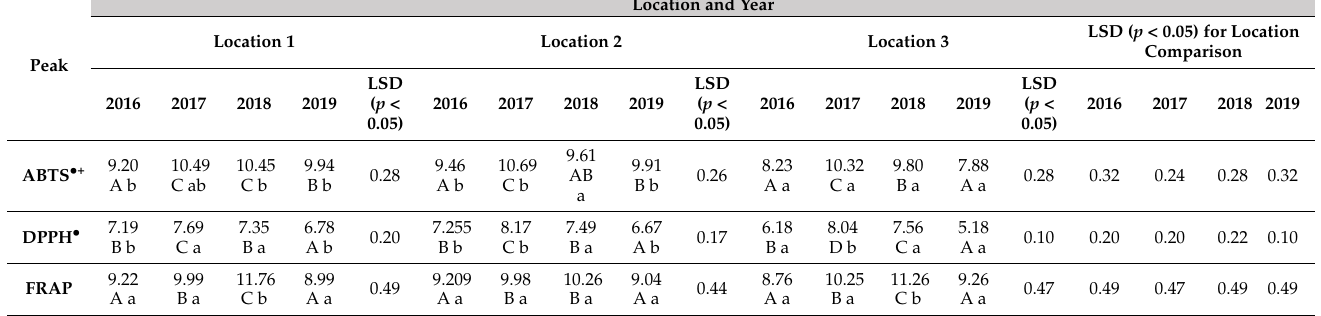
Table 4. In vitro antioxidant capacity (mmol TE/100g fw) of Prunus lusitanica fruits grown under different agroclimatic conditions (locations and